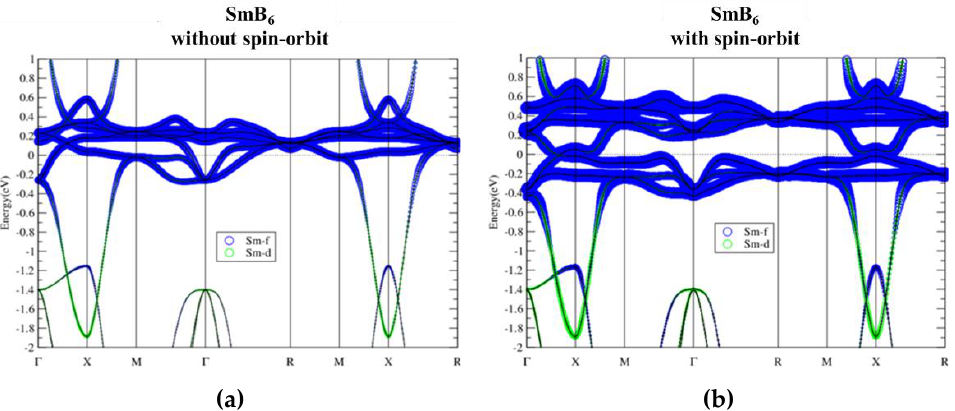
Figure 7. Band structures of SmB 6 without ( a ) and with ( b ) spin‐orbit interaction projected by f and d electrons of Sm.